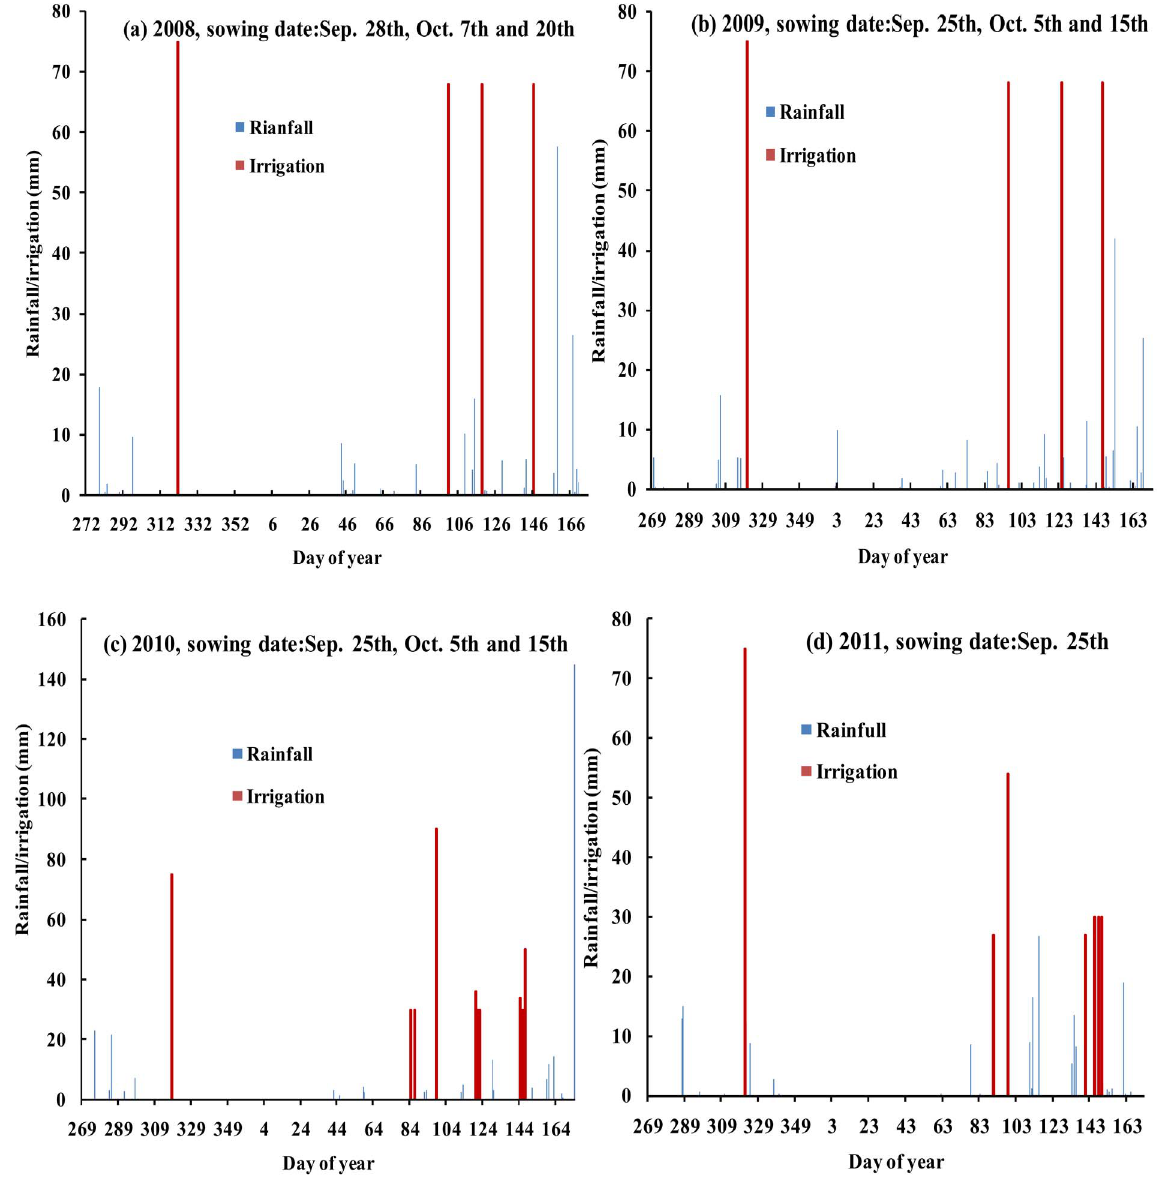
Figure 1. Daily rainfall, and supplemental irrigation for the Xiaotangshan site during the cropping seasons 2008/2009 (a), 2009/ 2010(b), 2010/2011 (c) and 2011/2012(d).